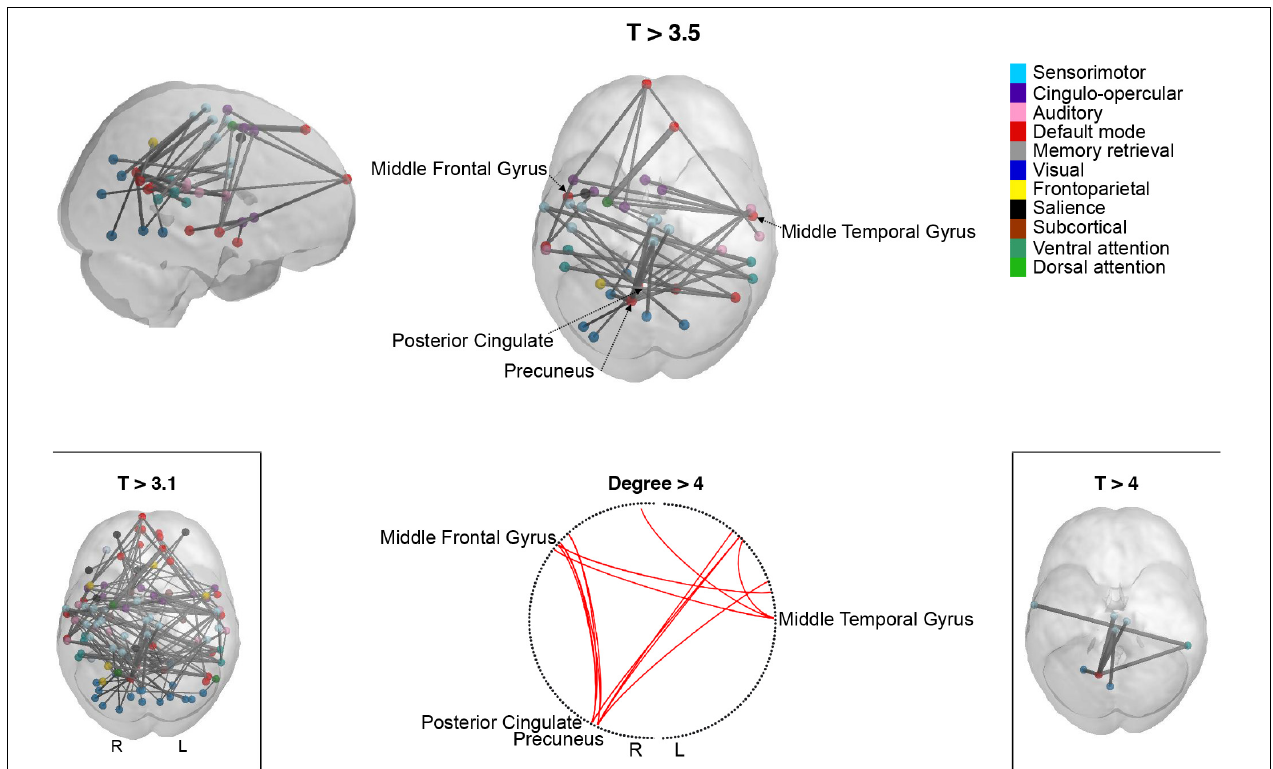
FIGURE 2 | Participants with more depressive symptoms exhibit lower correlations within a specific subsystem revealed by network-based statistic (NBS). Cortical representation of the NBS-derived whole-brain functional network comprising reduced connectivity connections in high compared to low MDI for three different t-thresholds (T): T > 3.1, T > 3.5, and T > 4. The circle plot shows the highest degree ( > 4) nodes in the network. Spheres represent the coordinates of the NBS-derived regions. Spheres are color-coded according to the functional network they belong to, as described in Power et al. (2011). L, left; MDI, Major Depression Inventory; R,